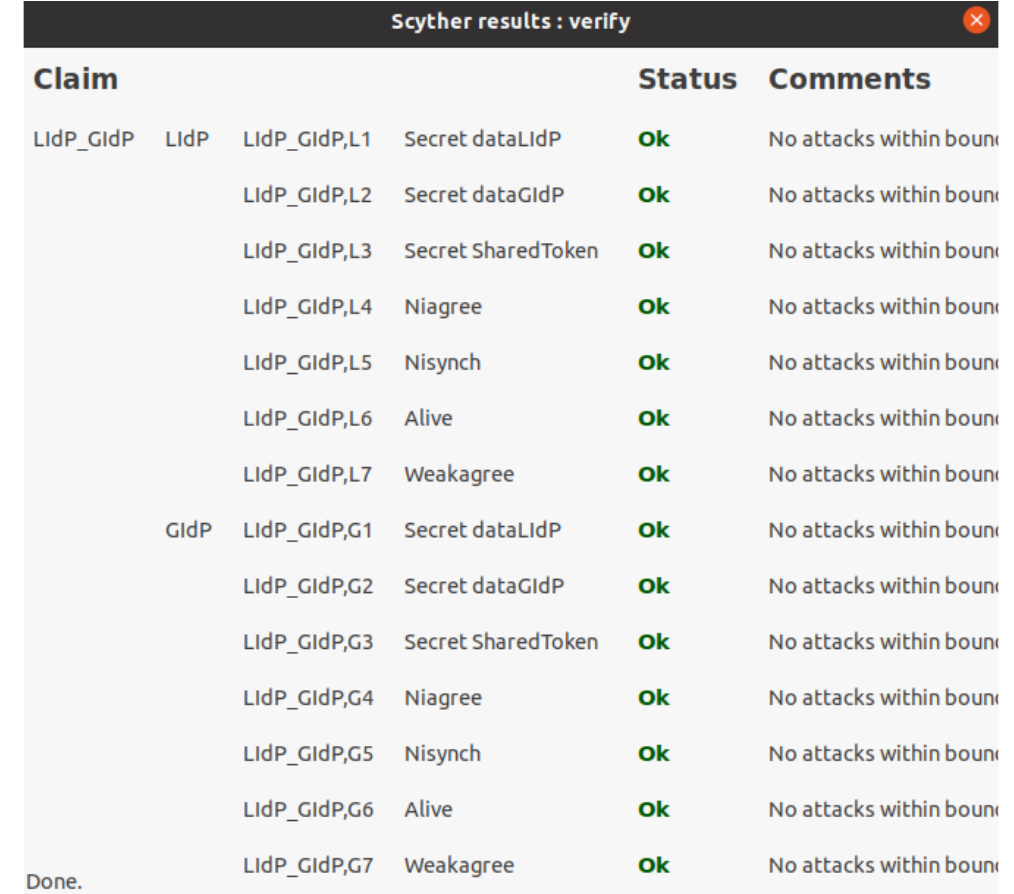
Figure 15. Scyther verification results for interaction between LIdP and GIdP.